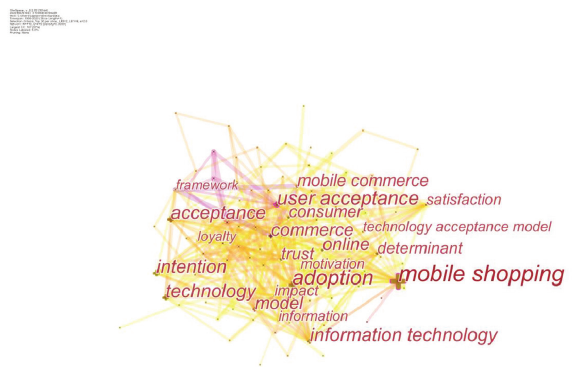
Figure 1: The keyword cooccurrence map of mobile shopping literature. Table 1: The researches of consumer intention and behavior of mobile